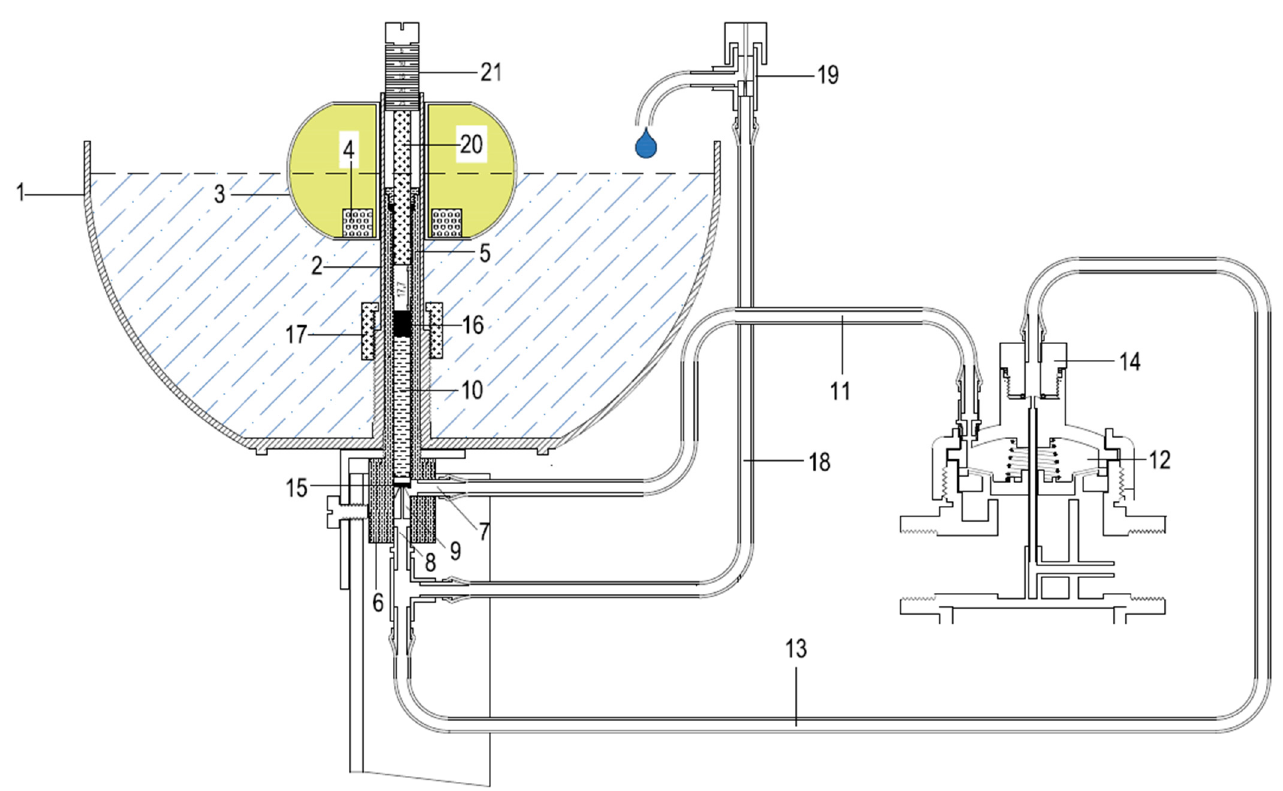
Figure 1. Drawing details of a Hydraulic Evapotranspiration Multisensor.